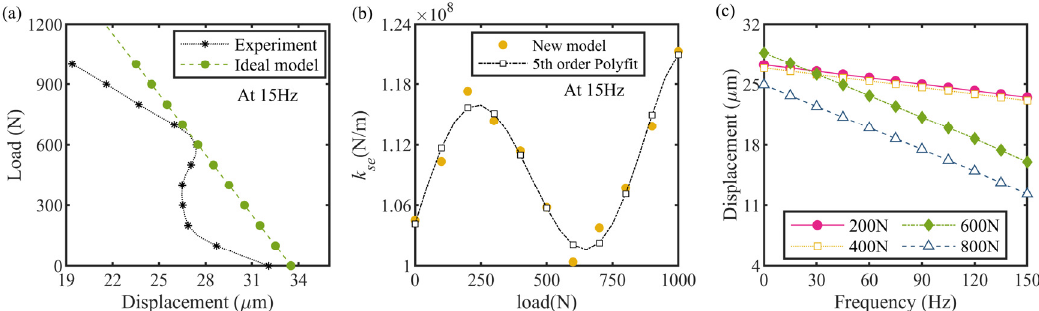
Figure 6. PZT stack’s performance. ( a ) Load versus displacement; ( b ) equivalent stiffness versus load; ( c ) displacement versus drive frequency.